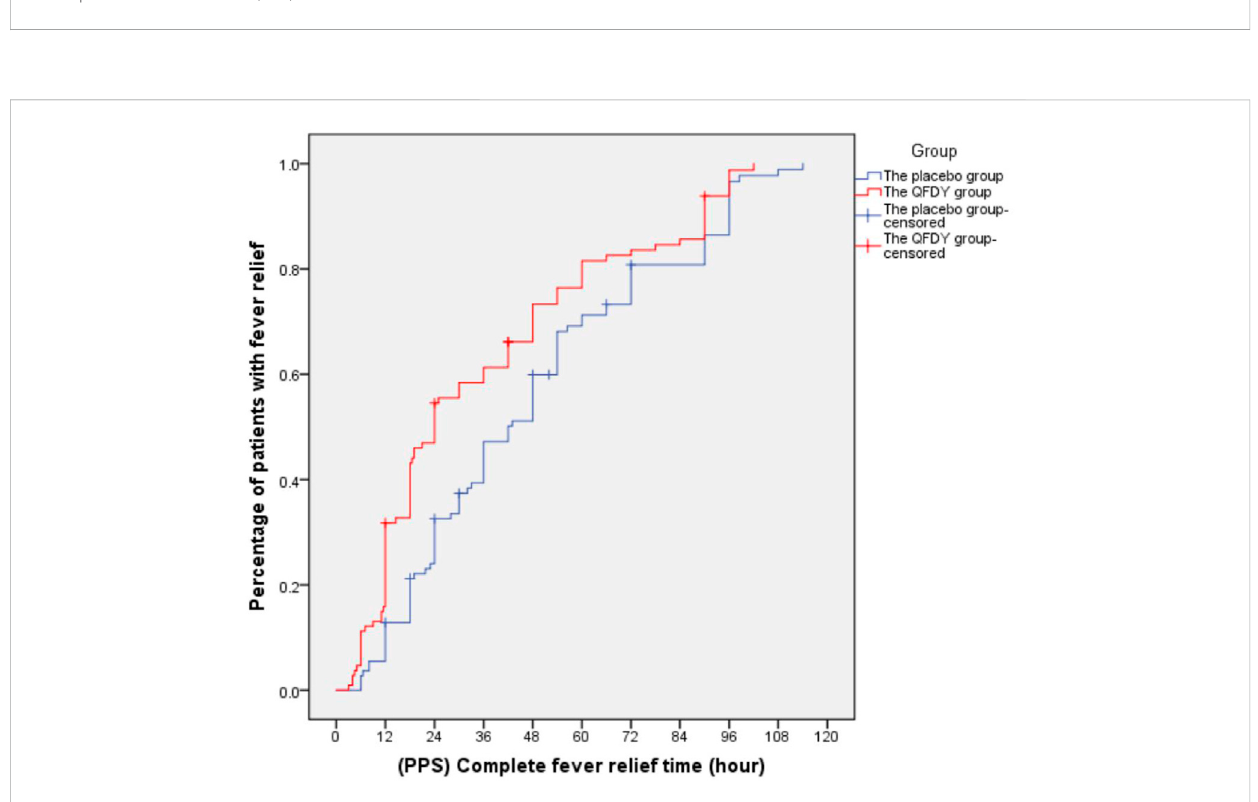
FIGURE 3 Complete fever relief time (FAS).